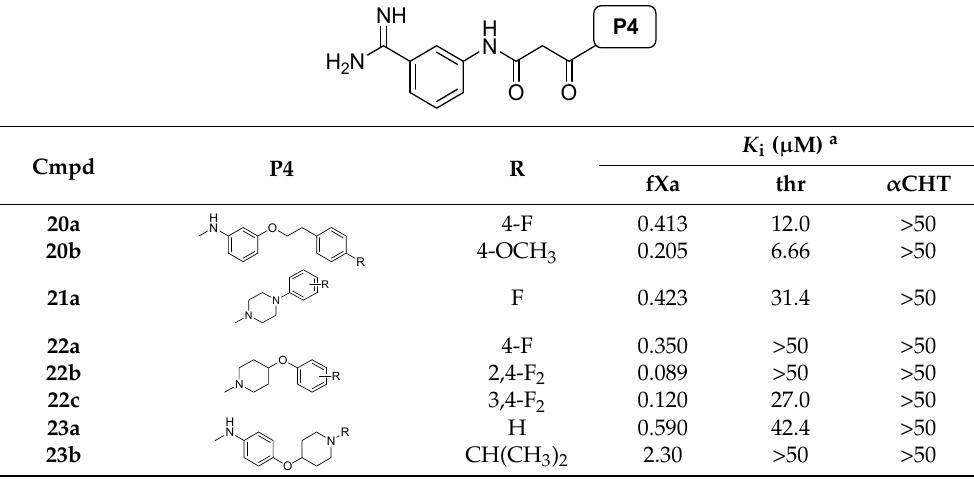
Table 4. Effects of replacement of the P4 group on inhibition of fXa, thr, and α‐ CHT. a See footnotes Table 1.